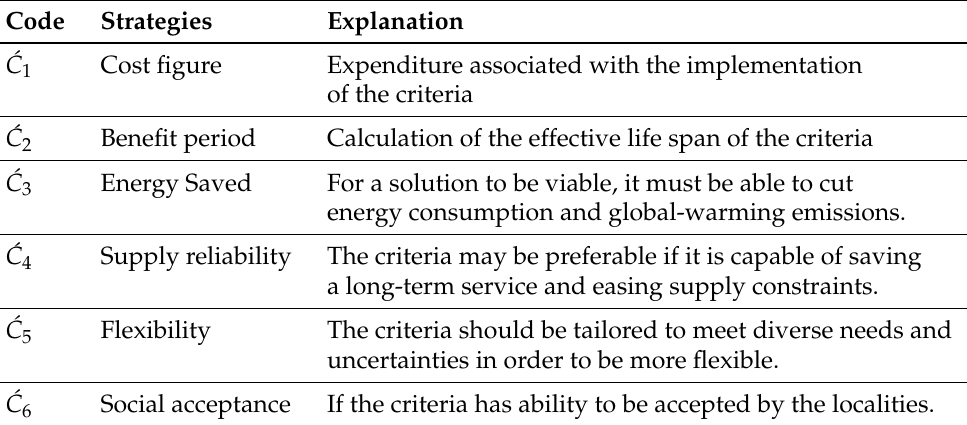
Table 6. Explanation of the evaluation criteria.